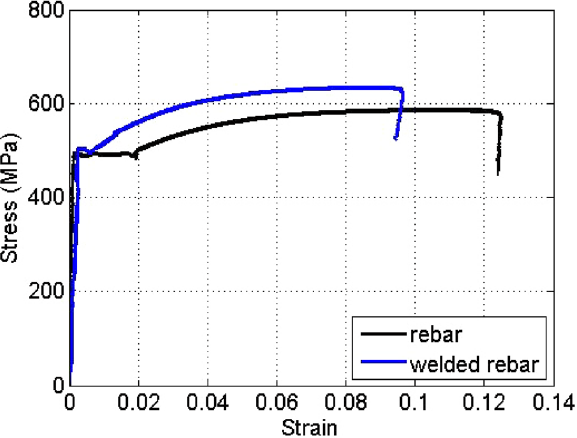
Fig. 3 Tensile test results for an 18 mm diameter single rebar and a rebar welded to plate.